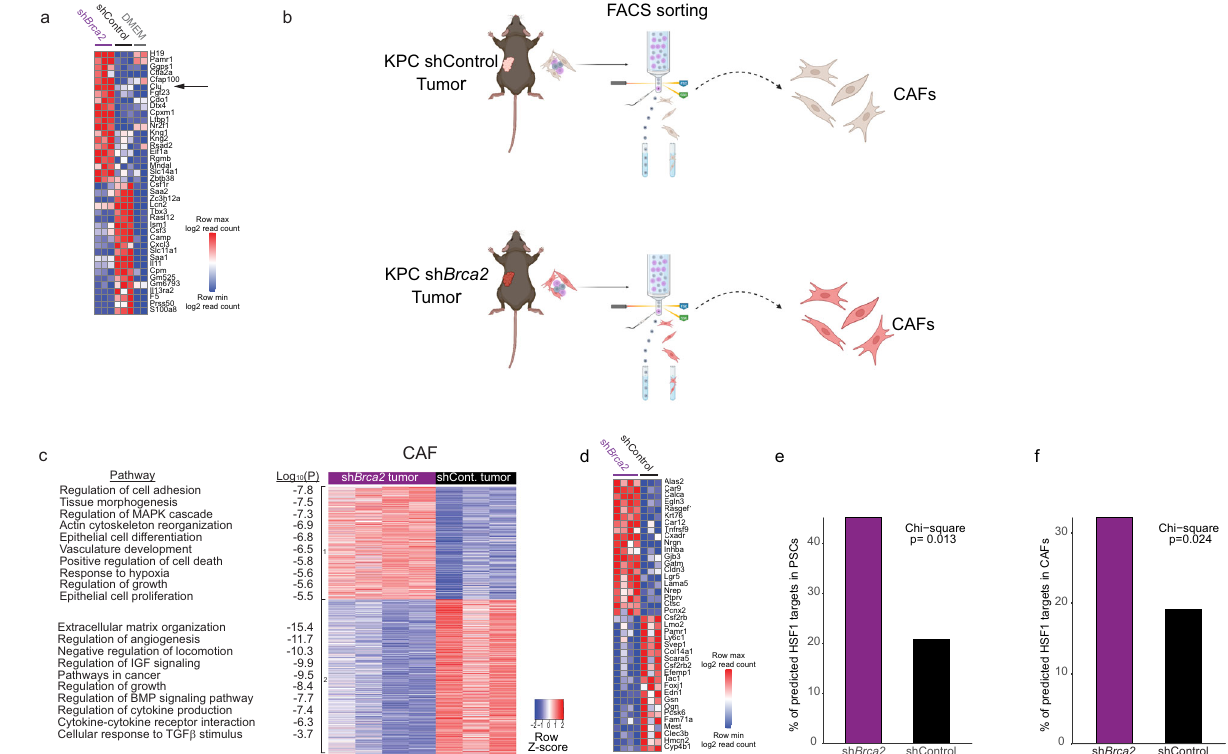
Fig. 5 | BRCA2 expression in the cancer cells affects the transcriptional pro fi le of PSCs and CAFs. ( a ) A heatmap representing the 20 most upregulated genes in KPC-sh Brca2- CM-treated PSCs compared to shControl, (see Methods and Sup- plementary Data 8, tab 7), and the 20 most upregulated genes in KPC-shControl- CM-treated PSCs (compared to sh Brca2 ). Clu is marked by an arrow. n =2 biolo- gically independent domes for DMEM treated PSCs and n =3 biologically inde- pendent domes for shControl-CM-treated and KPC-sh Brca2- CM-treated PSCs. ( b ) Schematic representation of the work fl ow. 2×10 4 KPC-sh Brca2 or KPC-shControl cellswereinoculated intothe pancreataof syngeneicC57BL/6Jmice.Threeweeks later the mice were sacri fi ced, tumors were dissected and CAFs were isolated by FACSsorting(seeMethods).Theschemewasgeneratedwithbiorender.com.( c , d ) RNA-seq analysis of CAFs from KPC tumors. n =3 mice for KPC-shControl tumors